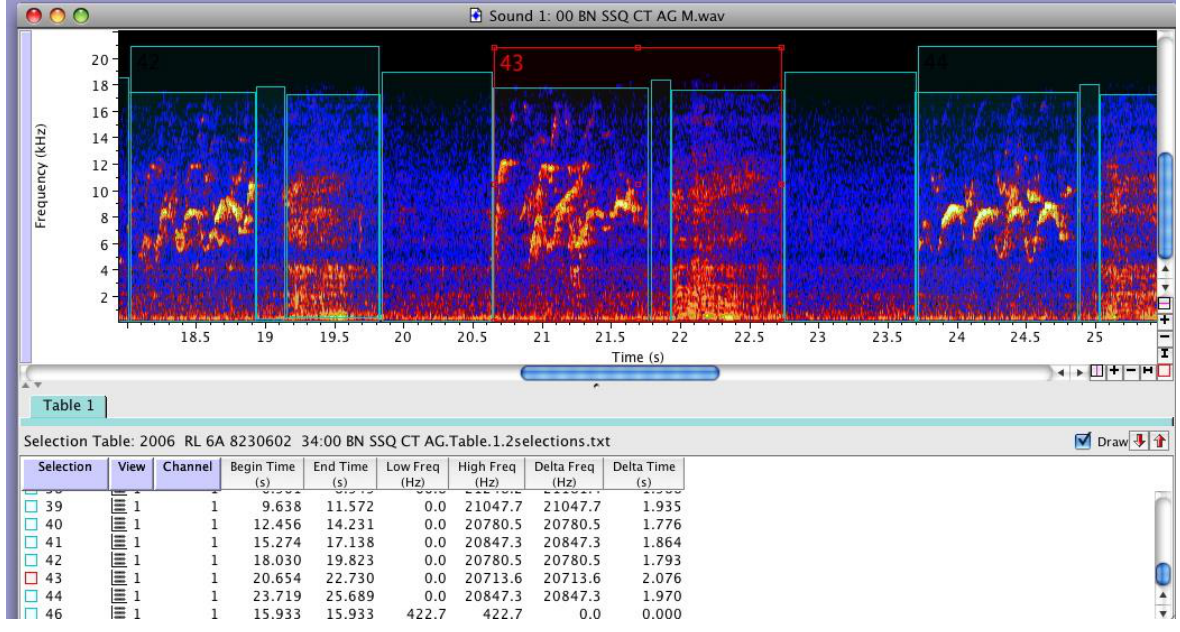
Figure 2. Example of a spectrogram and Raven measurements of a bottlenose dolphin whistle/buzz bout. Included are duration measurements of whistles, inter-signal interval (ISI) between the whistle and the buzz, and the buzz. Also measured is the duration of the combined whistle/ISI/buzz as a “bout” (43) and the ISI between “bouts” that are spaced between bouts